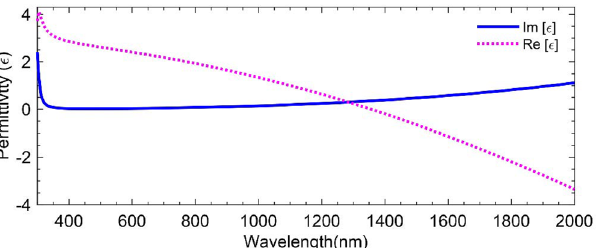
Figure 2. Real and Imaginary part of the permittivity of the AZO through the Drude-Lorentz